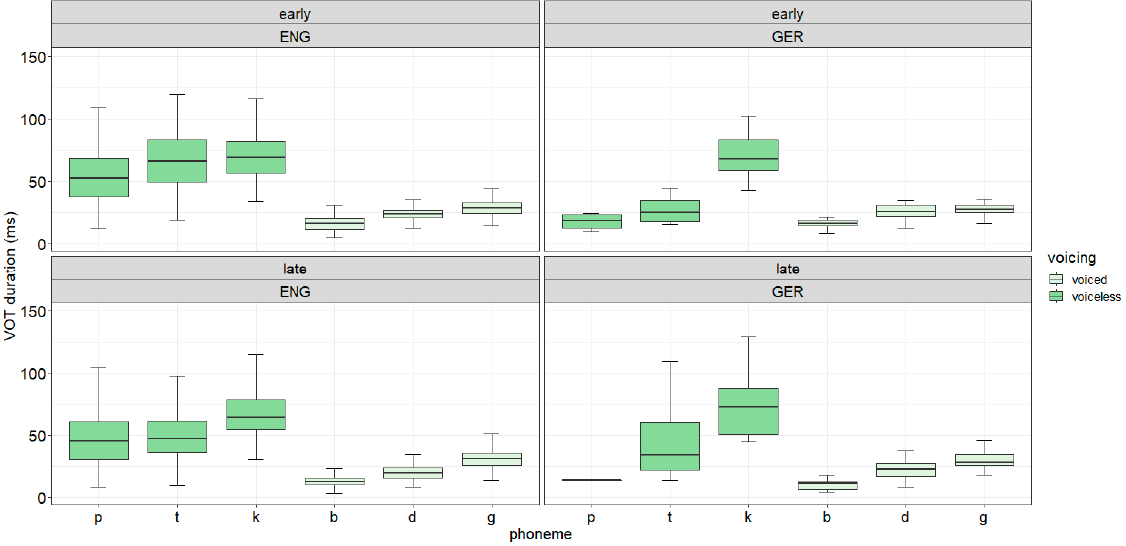
Figure 3. Comparison of VOT durations (in ms) of AS’s English (ENG) and German (GER) plosives.